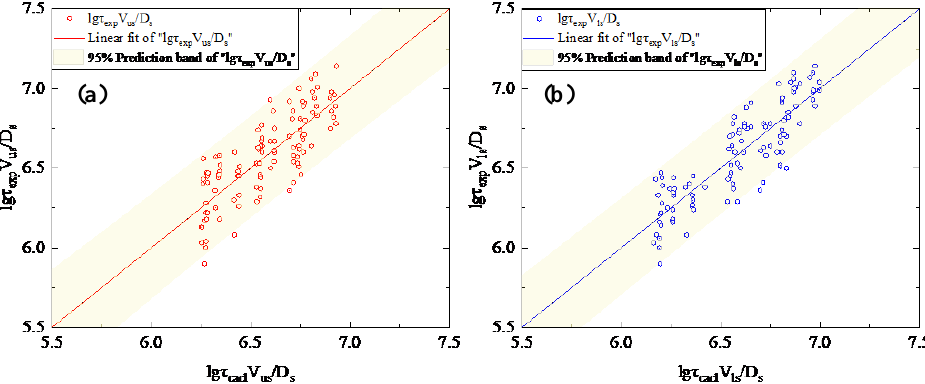
Figure 11. Comparison of experimental lg τ V s / D s with calculated ones for upper side nozzle ( a ) and lower side nozzle ( b ), respectively, using proposed Equations (21) and (22).